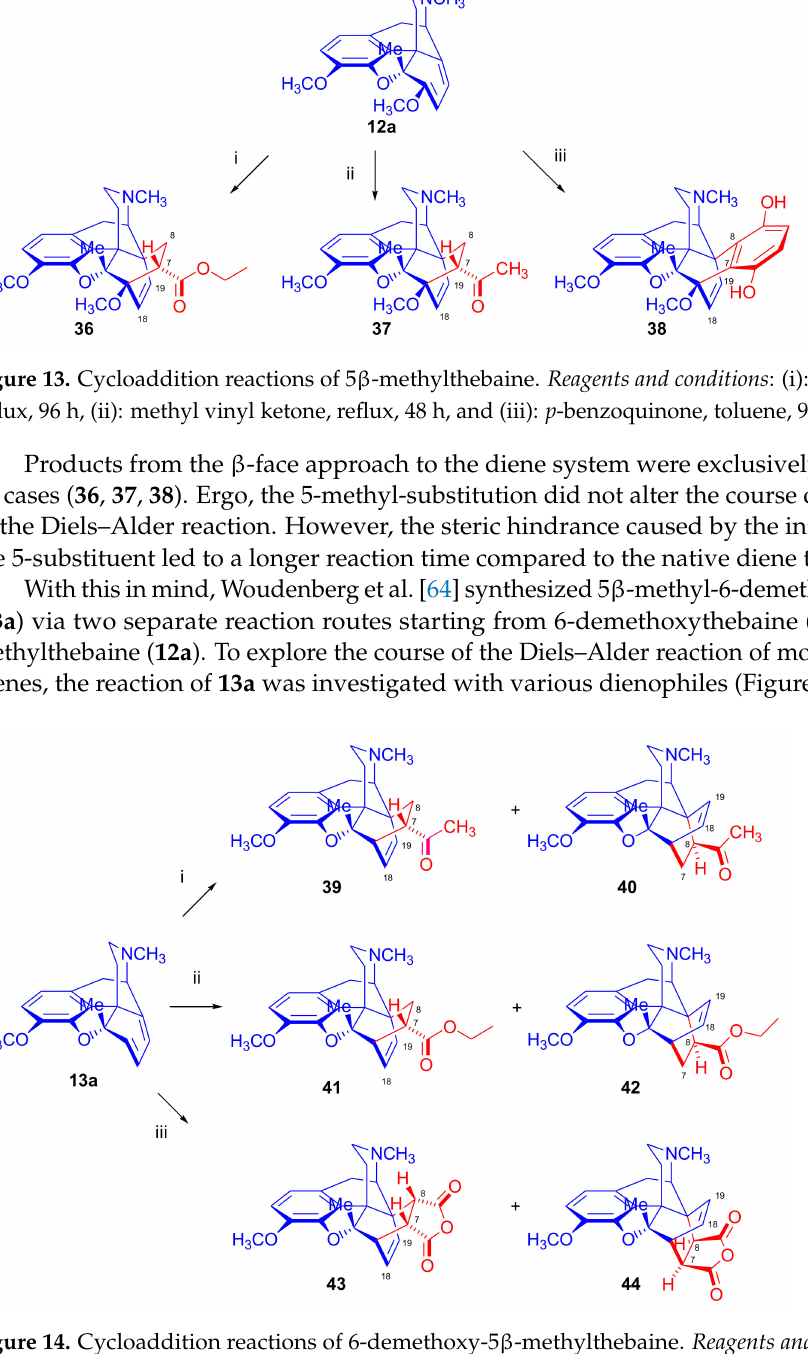
Figure 14. Cycloaddition reactions of 6-demethoxy-5 β -methylthebaine. Reagents and conditions : (i): methyl vinyl ketone, reflux, five days (ii): ethyl acrylate, reflux, five days, and (iii): maleic anhydride, toluene, reflux, ten